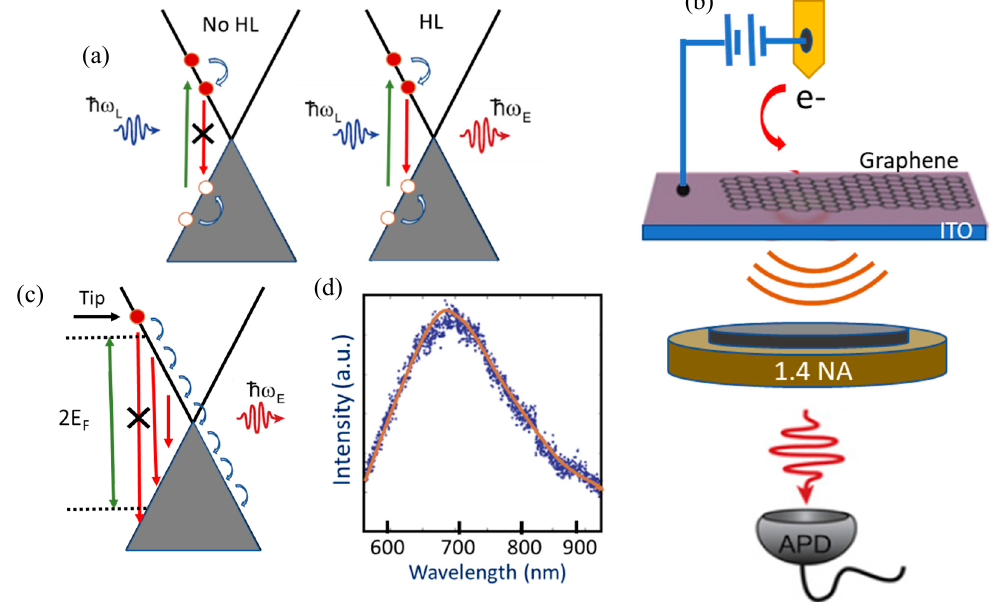
Figure 10. STM hot luminescent from graphene. ( a ) The diagram demonstrates the hot luminescence from graphene. In the case of undoped graphene when a photon with energy ( (cid:125) ω L ) used excite hole-electron pair, no hot luminescent observed, because of the non-radiative combination of the electron-hole pair. However, in the case of doped graphene with enough bandgap, the hot luminescent is observed with radiative decay of electron-hole combination. ( b ) The experimental setup is demonstrated in the diagram with the doping mechanism of graphene due to the substrate and tip. ( c ) The schematic shows the hot luminescent process in graphene; the grey shaded area shows the energy level < 2E F required for radiative decay. The electrons with > 2E F energy induce non-radiative decay presented with a dashed arrow. ( d ) The electroluminescent spectra from single-layer graphene under V B = 3 V [23].